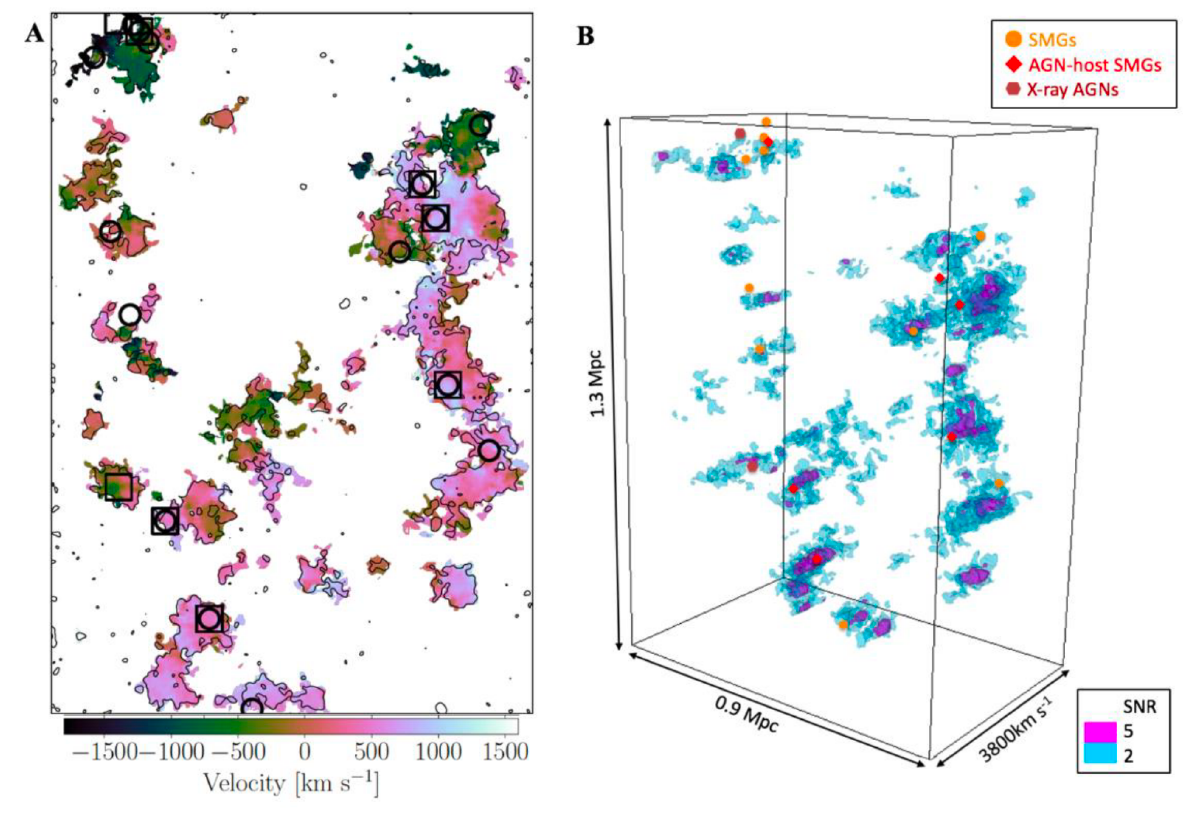
Figure 12. ( A ) Velocity map of Ly α emission from MUSE. Contours show Ly α surface brightness greater than 0.3 × 10 − 18 erg s − 1 cm − 2 . Circles (squares) indicate the positions of SMGs (X-ray AGN). ( B ) The Ly α filaments in three-dimensions. Blue and magenta denote SN > 2 and > 5 voxels. The locations of SMGs, AGN-host SMGs, and X-ray AGN are shown in orange circles, red diamonds, and brown hexagons. The DSFGs and AGN are cospatial with the Ly α filaments on megaparsec scales. Figure reproduced from Figure 3 in Umehata et al. [550] and reprinted with permission from